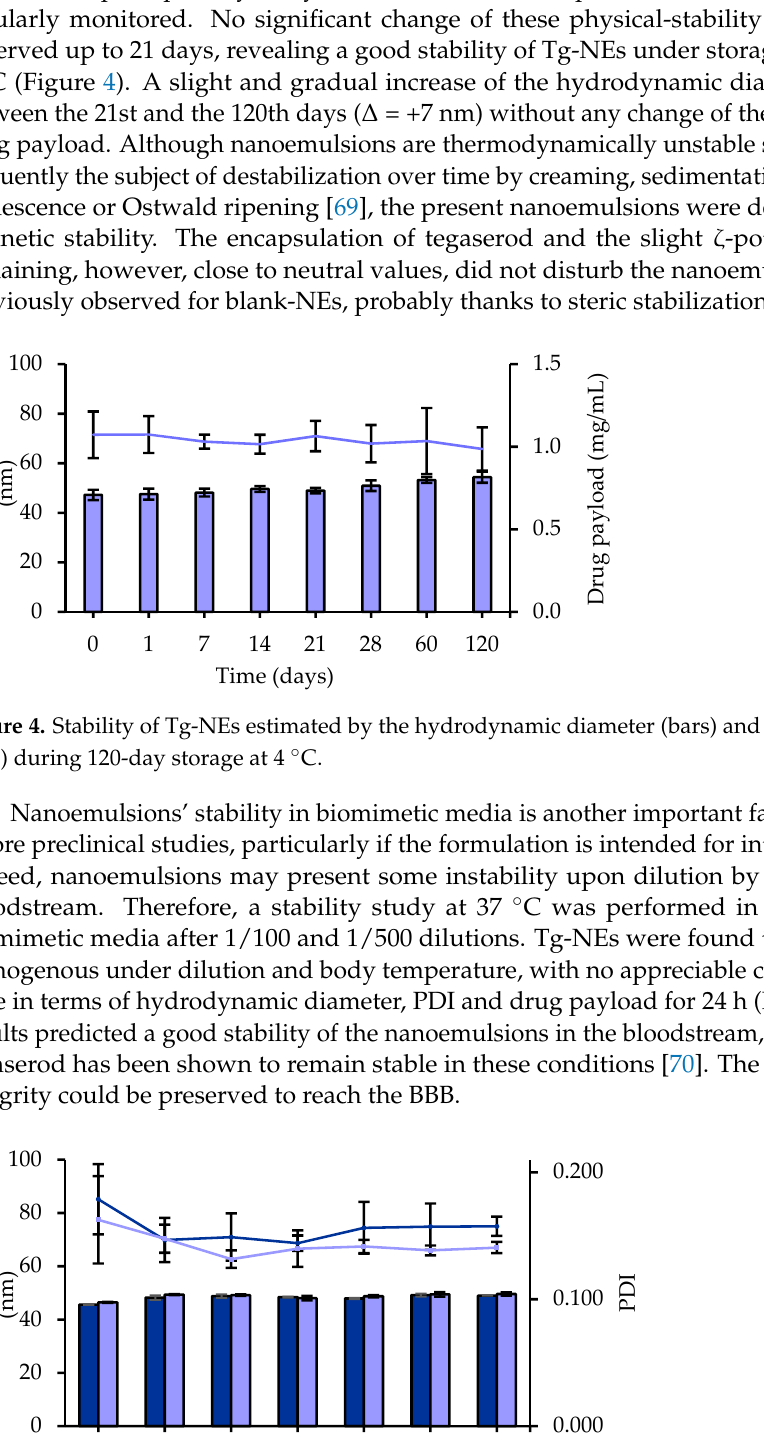
( b ) Figure 3. Macroscopic observation of Blank-NEs ( a ) and Tg-NEs ( b ). Moreover, thanks to an original and suitable phosphate buffer as the aqueous phase, the pH and osmolarity of Tg-NEs were well suited for intravenous administration (Table 4).